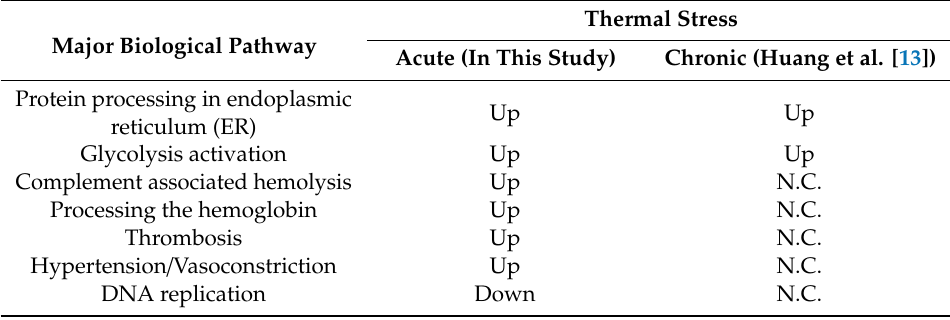
Table 2. Comparison of changes of major biological pathways between acute and chronic thermal stress